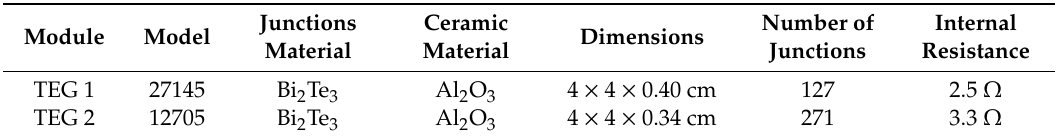
Table 1. Properties of the selected TEG